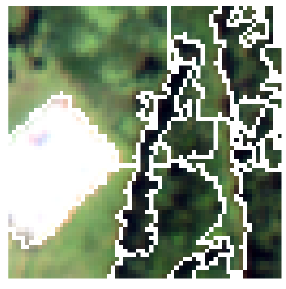
Figure 5. Segmentation of Fort A.P. Hill chip.